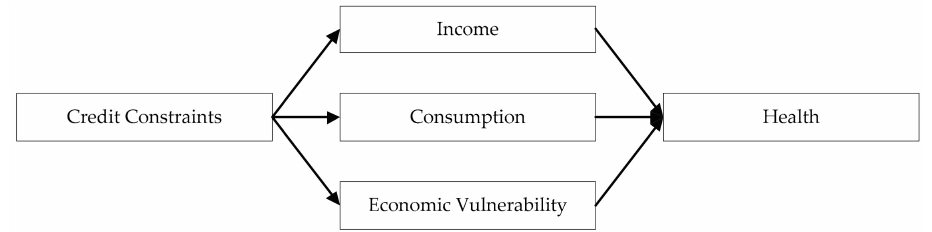
Figure 1. Paths of credit constraints impacting